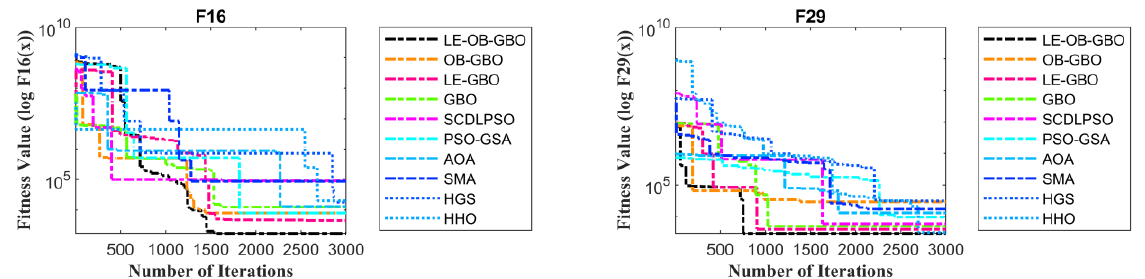
Figure 3. Convergence curve of F16 (hybrid) to F29 (composite).